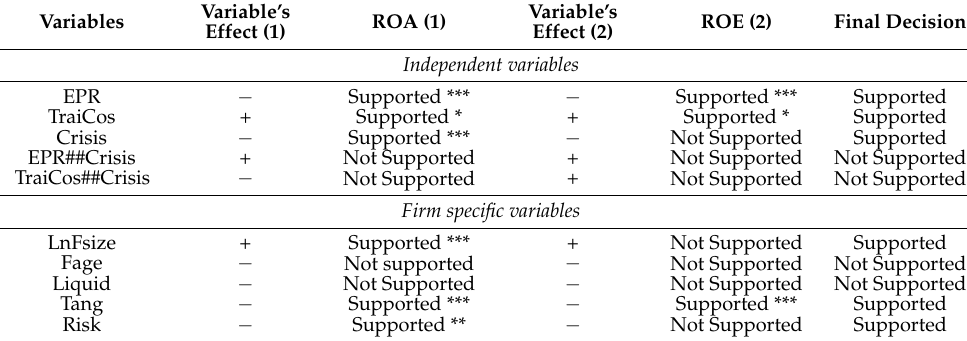
Table 8. Summary of hypothesis verification of model (1) and